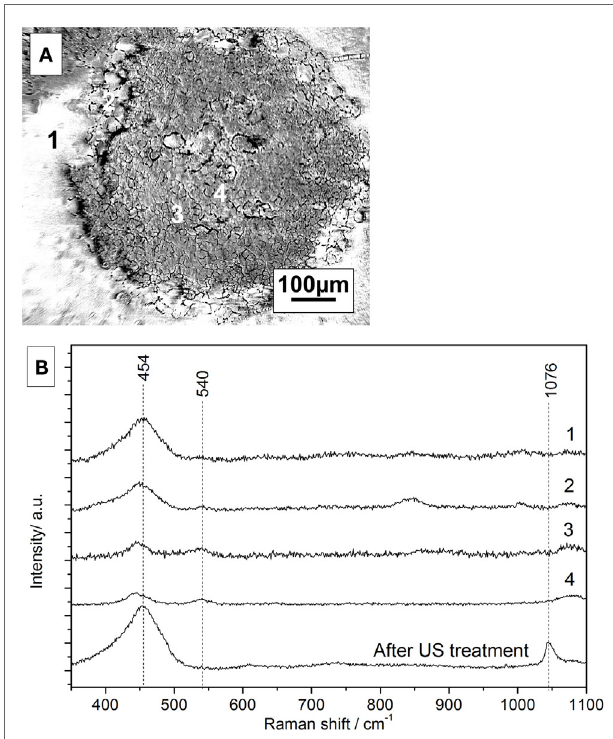
FigUre 11 | (a) Microscope picture of coated surface after polarization and 14 h of immersion, (B) corresponding Raman spectra of the selected